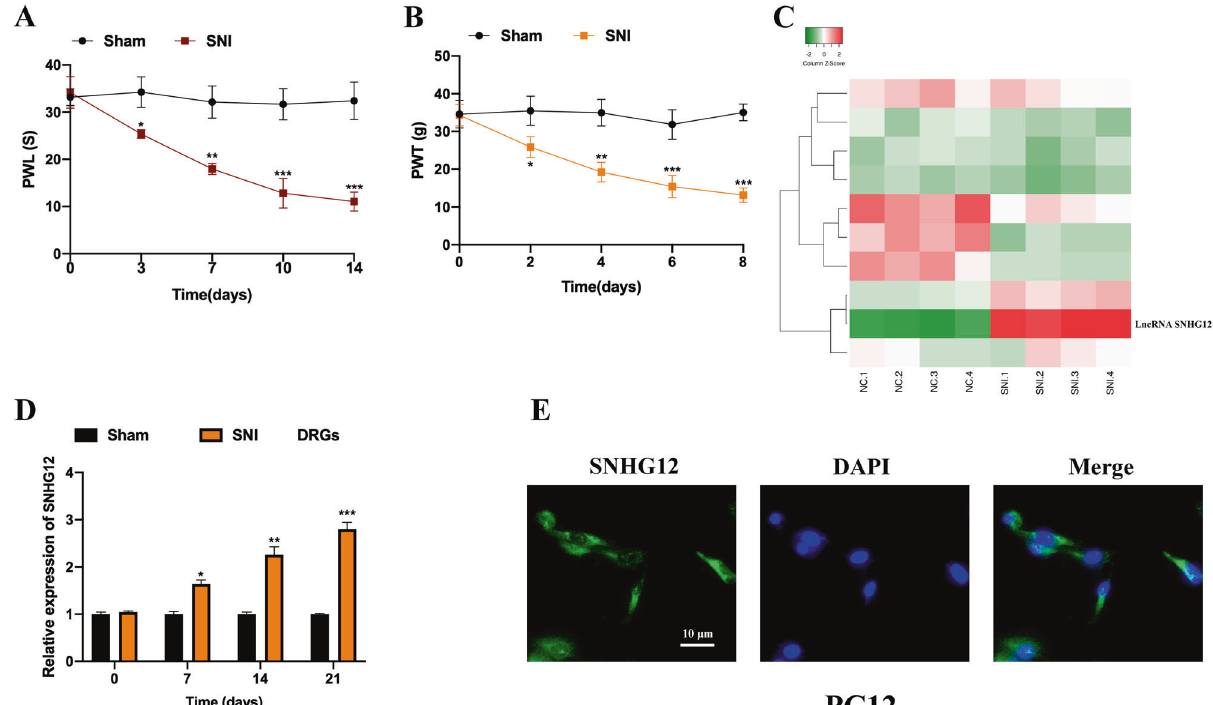
Fig. 1 LncRNA SNHG12 expression is upregulated in the DRGs of SNI rats. A PWL and B PWT assays were conducted to examine the SNI and Sham rats. C Microassay analysis results of lncRNA expression pro fi le of the DRGs tissues from SNI or Sham group rats. D LncRNA SNHG12 expression in DRGs from SNI or Sham group rats was detected by qRT-PCR. E Cell distribution of SNHG12 in PC12 cells was determined by an RNA-FISH assay. Experimental data are presented as mean ± SD. * P < 0.05, ** P < 0.01, *** P <